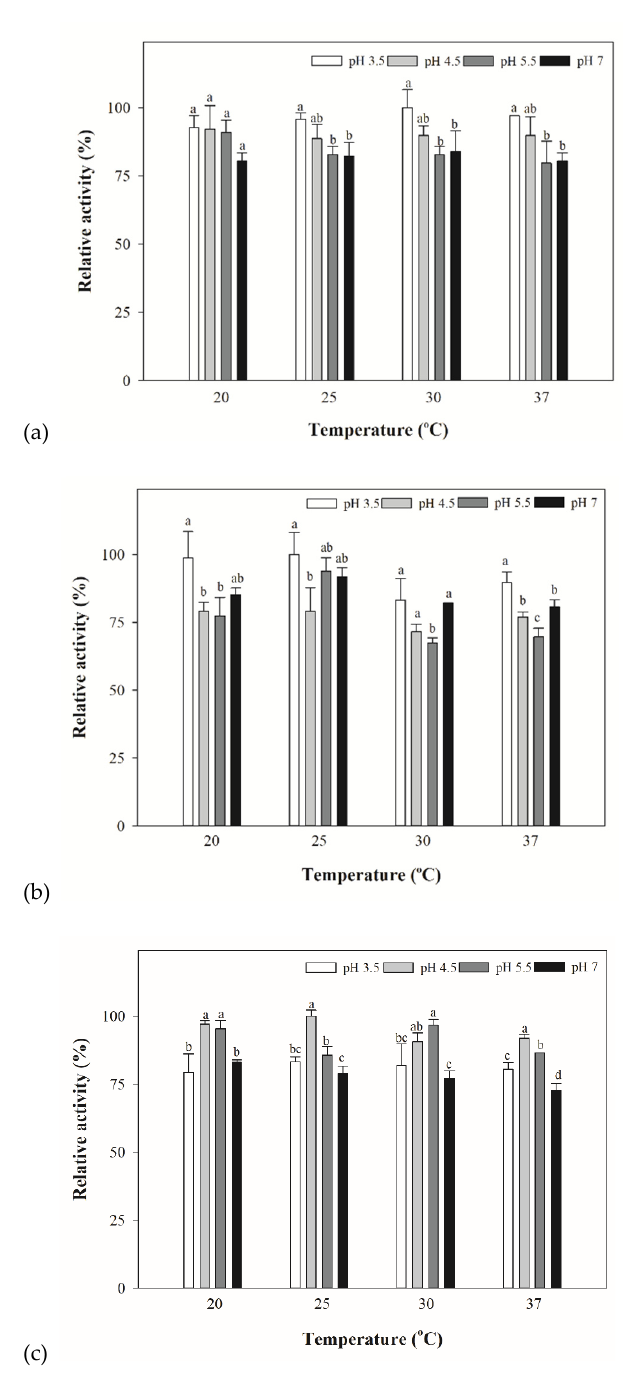
Figure 3. The β -lyase activity of ( a ) S. cerevisiae 21584, ( b ) K. lactis, and ( c ) Schizo. pombe yeast extracts at various temperatures and pH. The C-S β -lyase specific activities were determined by the DTNB assay using 1 mM L -cystathionine at 20, 25 30, and 37 ◦ C, and at pH values of 3.5, 4.5, 5.5, and 7.0. Relative activity of 100% represented the highest value among all the specific activities in different temperatures and pH. Data are expressed as mean ± standard deviation ( n = 3). Different lower case letters in the same grouped bars indicate significant differences ( p <